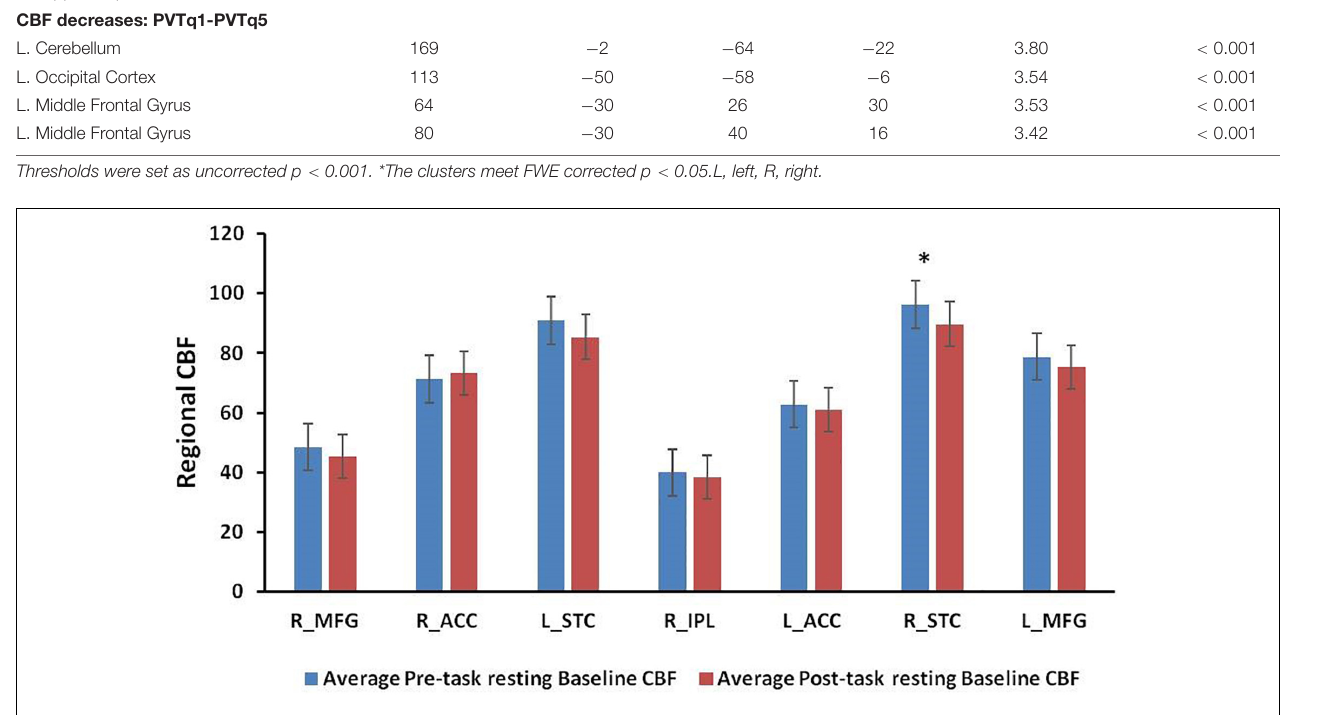
FIGURE 4 | Regional CBF values at pre-task and post-task resting baselines in the region-of-interests (ROIs) from previous healthy control study. * p <